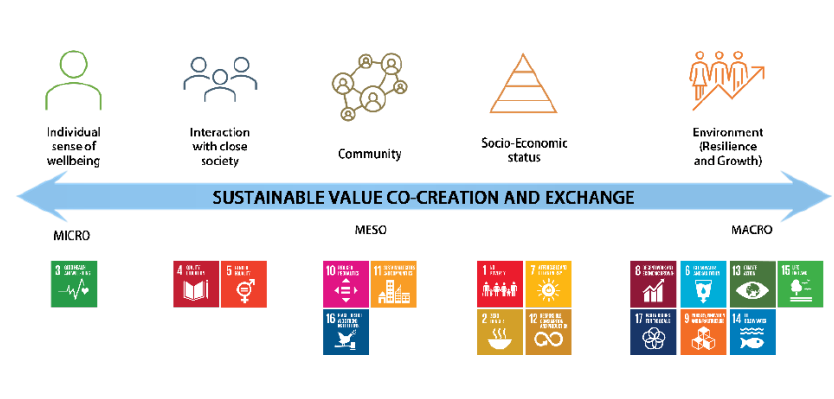
Fig. 1: The Context of Sustainable Value Exchange (By the Author – adapted from [11] and the literature on service science and sustainability science, connected to the SDG agenda 2030 of